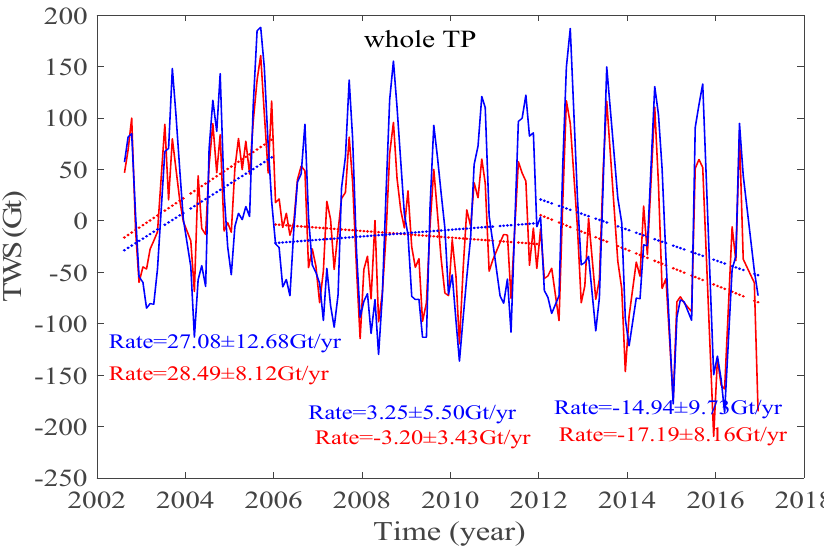
Figure 4. Time series of the water storage variations (TWS) on the Tibetan Plateau between August 2002 and December 2005, between January 2006 and December 2011, and from January 2012 to December 2016. Blue lines represent direct estimates from GRACE monthly solutions. Red lines show reconstructed mass variations by using a forward modeling technique. Blue dotted lines present a linear rate of direct GRACE estimates, and red dotted lines show a linear rate of reconstructed mass variations.